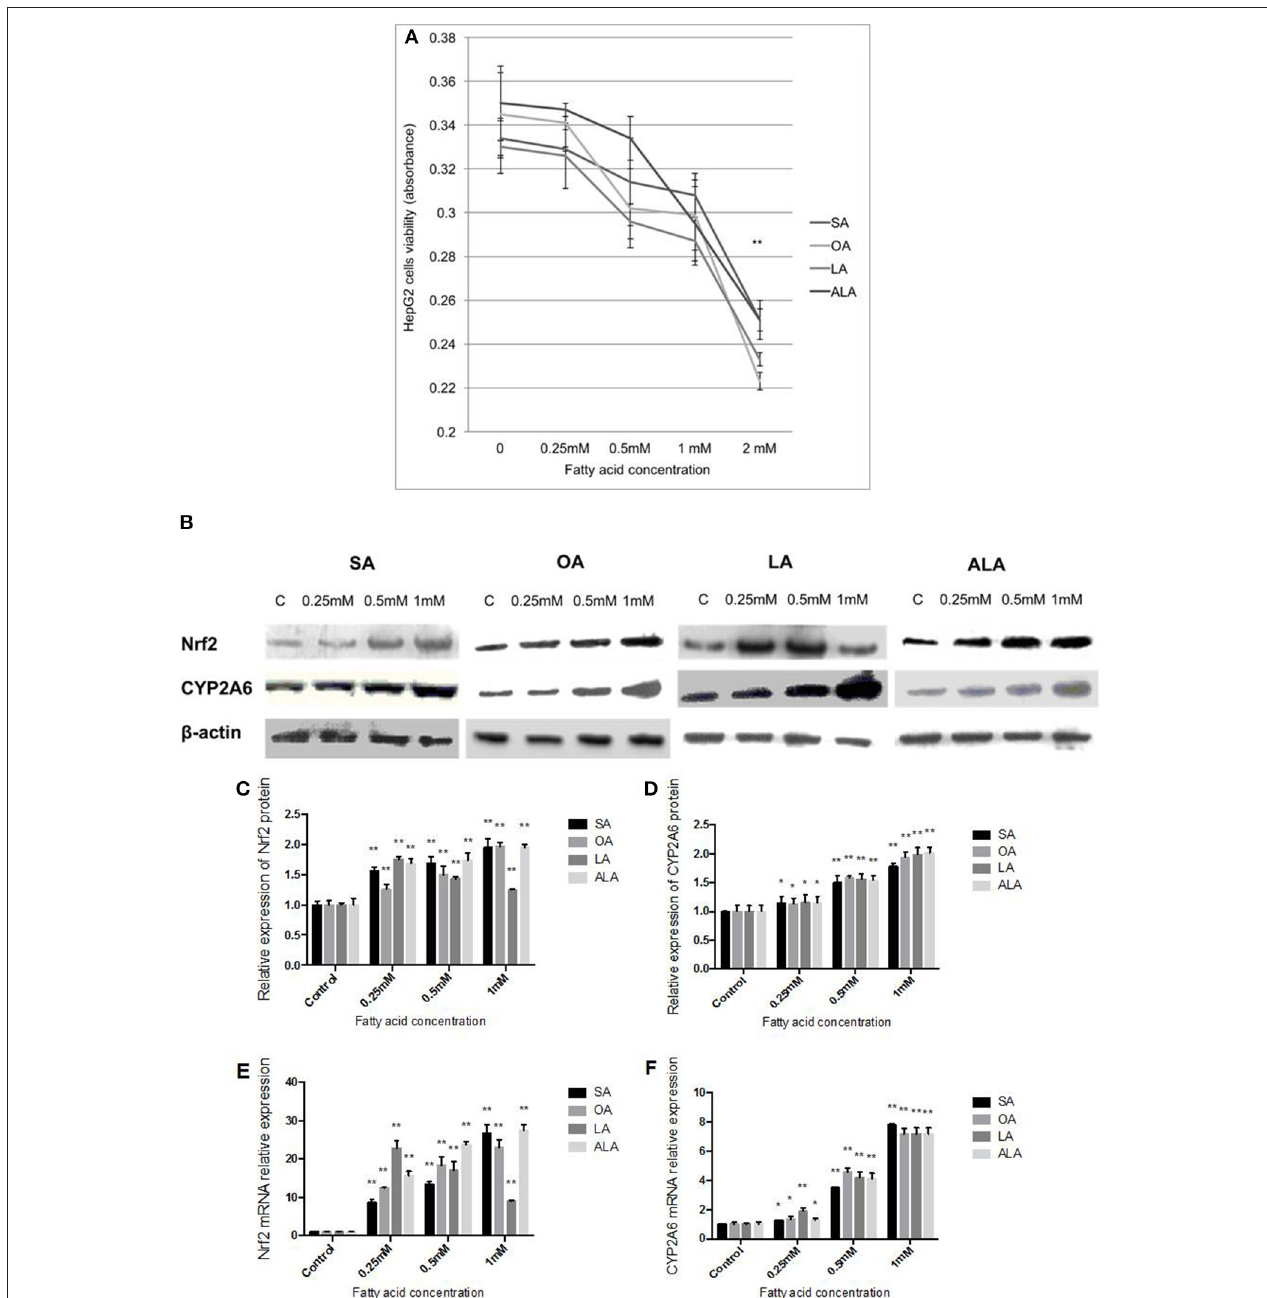
FIGURE 3 | Effect of 18-carbon fatty acid on Nrf2 and CYP2A6 expression in HepG2 cells. (A) HepG2 cells viability which were administered with increasing concentrations of SA, OA, LA, and ALA. The cells viability was represented by the absorbance. The effect of SA, OA, LA, and ALA on Nrf2 and CYP2A6 protein expression in HepG2 cells are exhibited in panel (B) . Nrf2 protein expression was quantified and shown in panel (C) . CYP2A6 protein expression was quantified and shown in panel (D) . The effect of SA, OA, LA, and ALA on Nrf2 and CYP2A6 mRNA expressions are shown in panel (E,F) , respectively. Asterisks * represent statistical difference caused by fatty acid administration from control cells. * 0.01 < P < 0.05, ** P < 0.01.